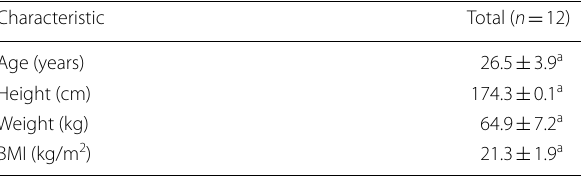
BMI body mass index a Values are presented as mean